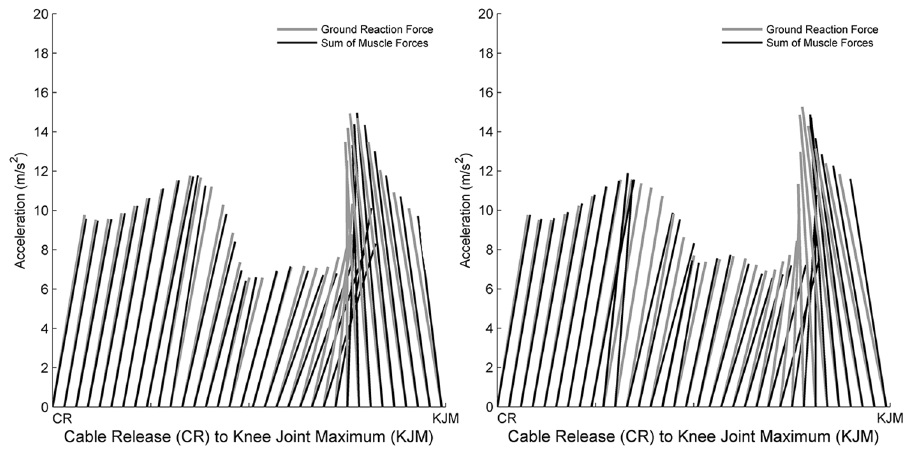
Fig 2. Vector plots for older adults (A) and younger adults (B) representing the acceleration induced by the experimentally measuredground reaction force and the acceleration induced by the sum of all muscle forces to the acceleration on the whole body COM. Each line representsthe resultant vector of the vertical and anterior-posterior acceleration caused by the groundreactionforce (in grey) and the sum of all muscle forces (in black) a respectively. X and Y axis are scaled